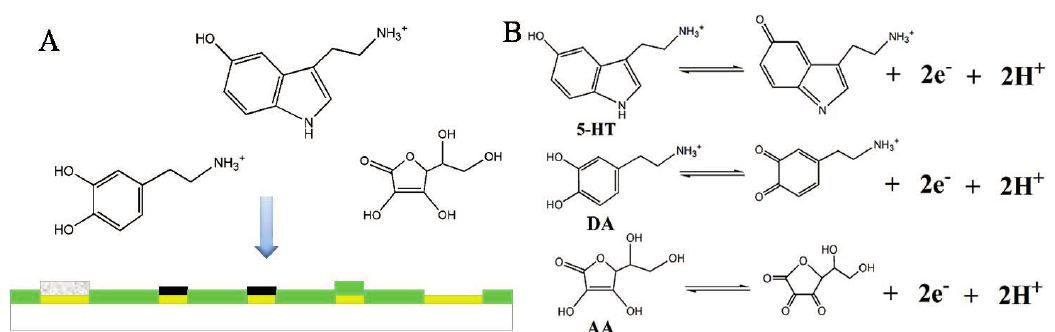
Figure 4. The electrochemical process of DA, 5-HT and ascorbic acid (AA). ( A ) Competitive diffusion in the solution and the CS-MWCNT hybrid film; ( B ) The principle of the oxidation